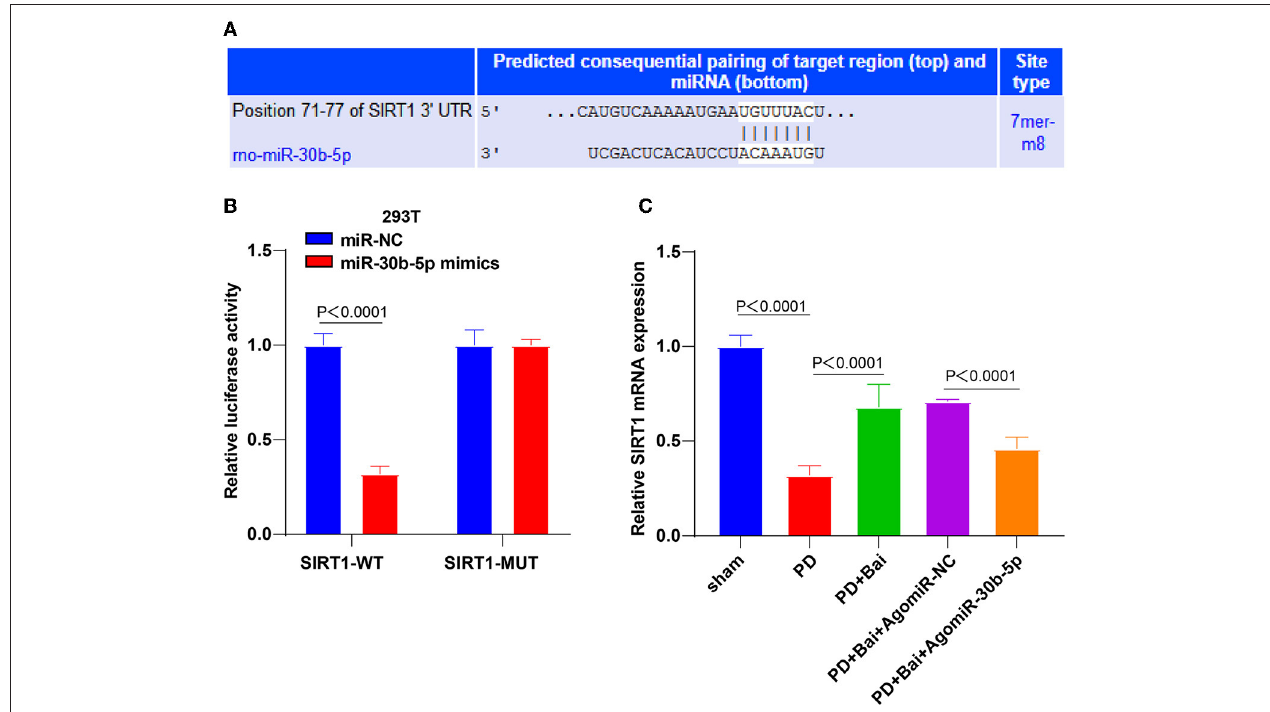
FIGURE 3 | miR-30b-5p targeted SIRT1. (A) The binding sites between miR-30b-5p and SIRT1 were predicted by TargetScan website; (B) the target binding relationship between miR-30b-5p and SIRT1 was verified by dual-luciferase assay; (C) the expression of SIRT1 was detected by RT-qPCR. Three independent repeated cell tests were performed. N = 6. The data in the figure are all measurement data, expressed as mean ± standard deviation, and analyzed by one-way ANOVA and Tukey’s multiple comparisons